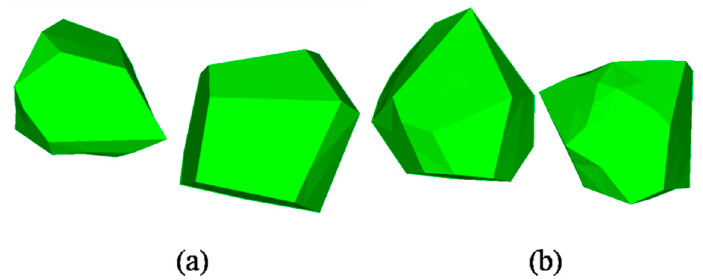
Figure 11. Different relative position of adjacent grains: ( a ) a corner on the surface ( b ) a corner on another corner.